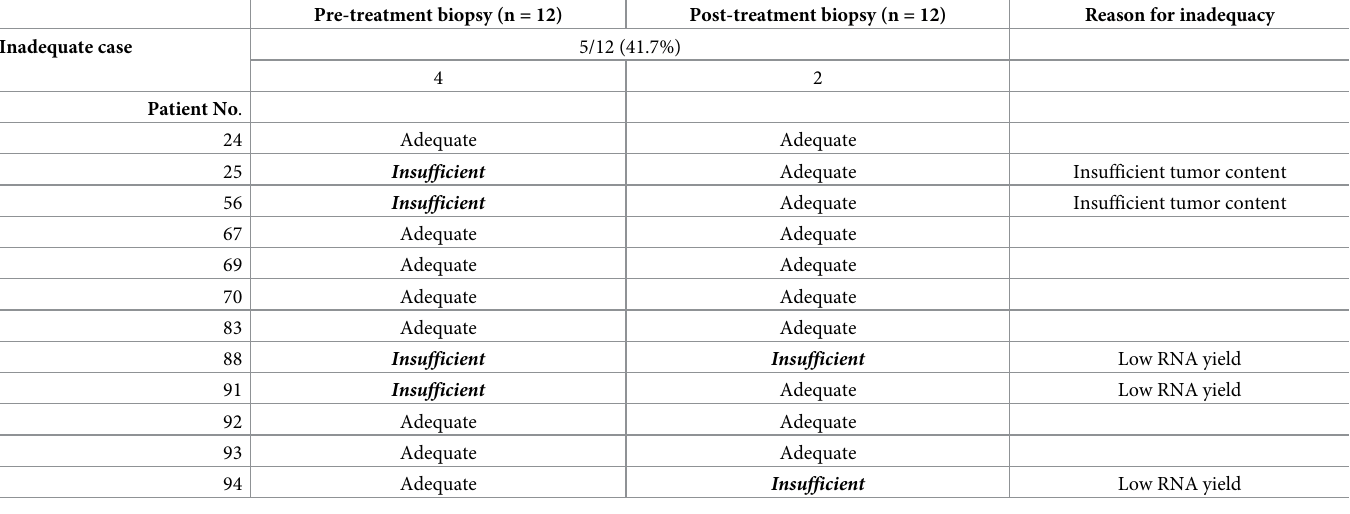
In this single-center study, we found that research biopsies performed percutaneously with image-guidance had 93.4% biopsy success rate, 90.2% complication-free rate, and 89.5% ade- quacy rate. To the best of our knowledge, this is the first report on the adequacy of research biopsy for pre-planned molecular tests as assessed by the sponsors of clinical trials. The rate of biopsy success, which was defined as providing sufficient amount of tissue for histopathologic confirmation of malignant lesion, was 93.4% in our study (93.6% in liver biop- sies [US-guided], 89.7% in lung biopsies [CT-guided]). This figure is comparable or higher Table 5. Adequacy of pre- and post- research